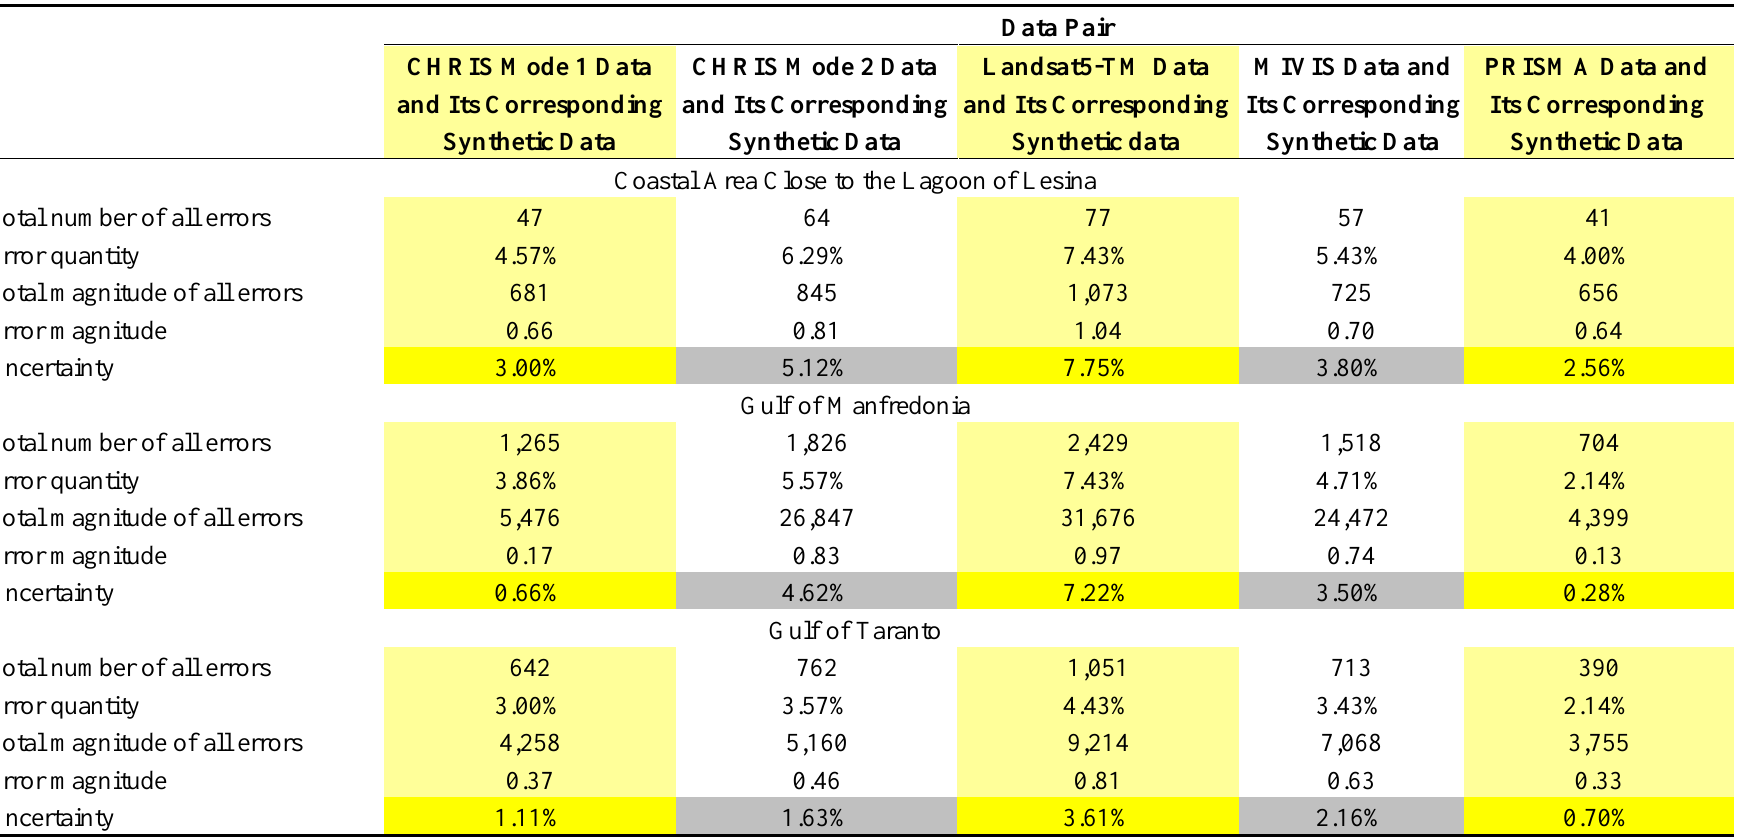
Table 5. The total number of the all errors, the error quantity, the total magnitude of all errors, the error magnitude and the value of the uncertainty (highlighted with darker color), which were obtained by the five data pairs for the three coastal sites, are